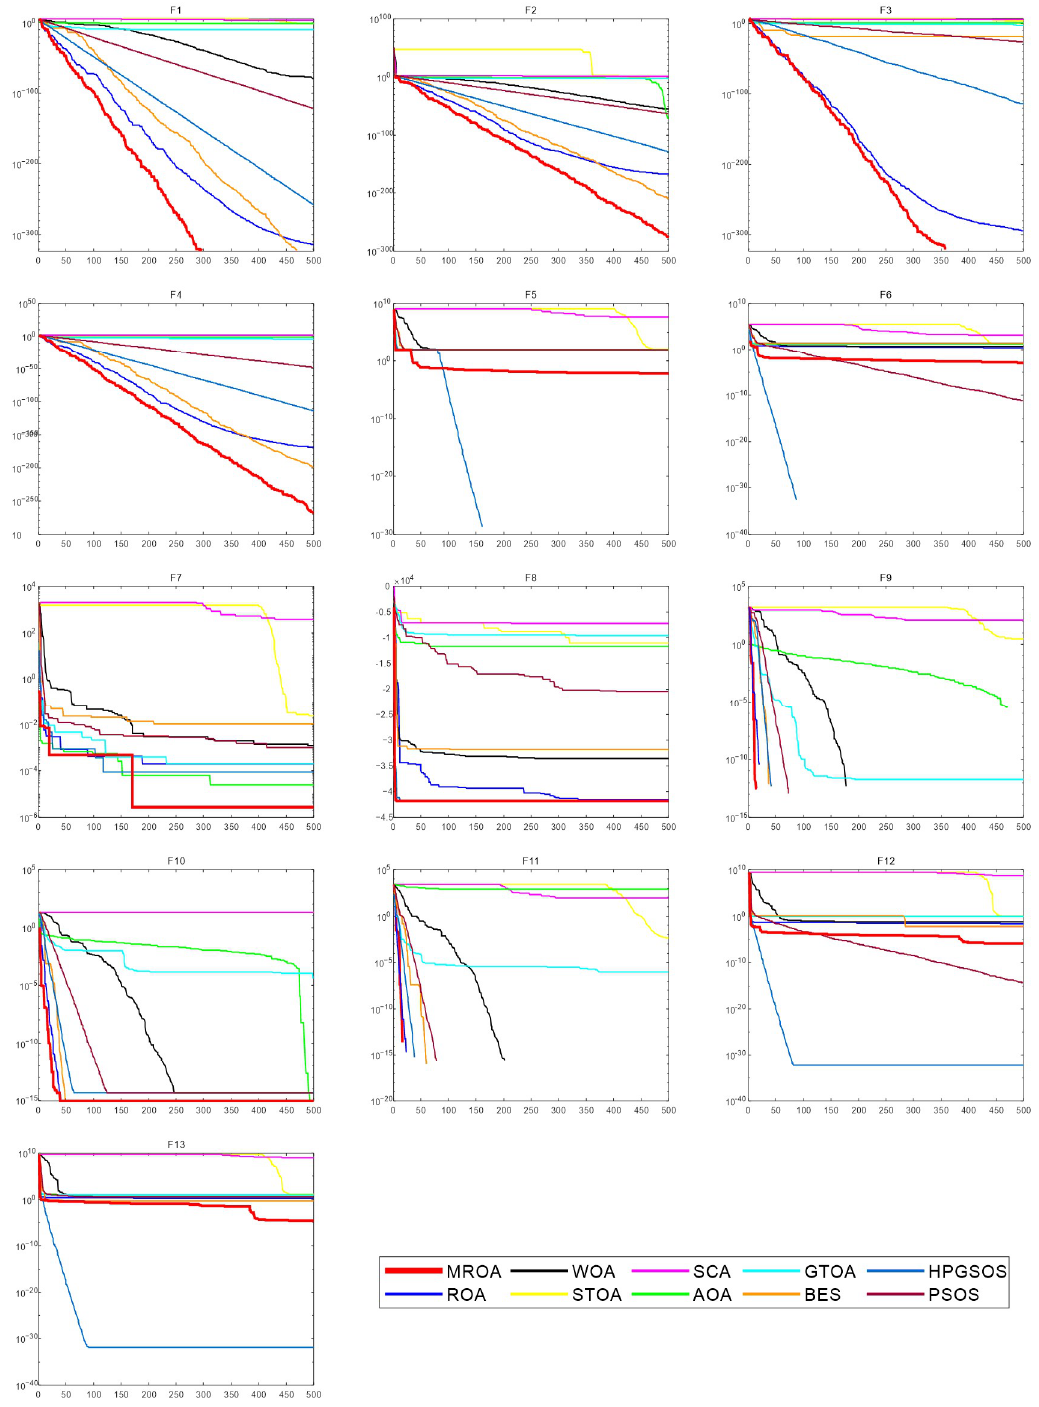
Figure 6. The convergence curves for the optimization algorithms on test functions (F1–F13) with dim = 100.